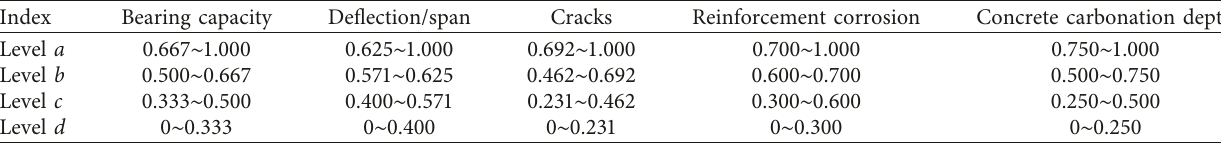
Table 4: Safety grades and corresponding (normalized) ranges of the five